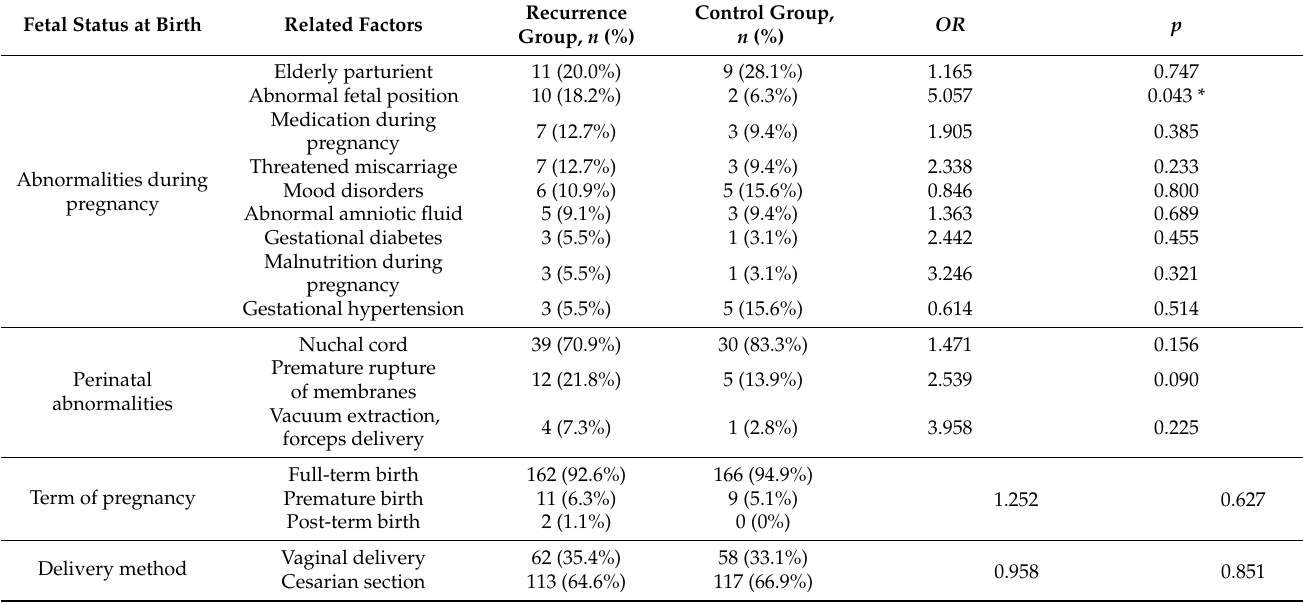
Table 2. Relationship between birth status and tic recurrence (non-modifiable factor).